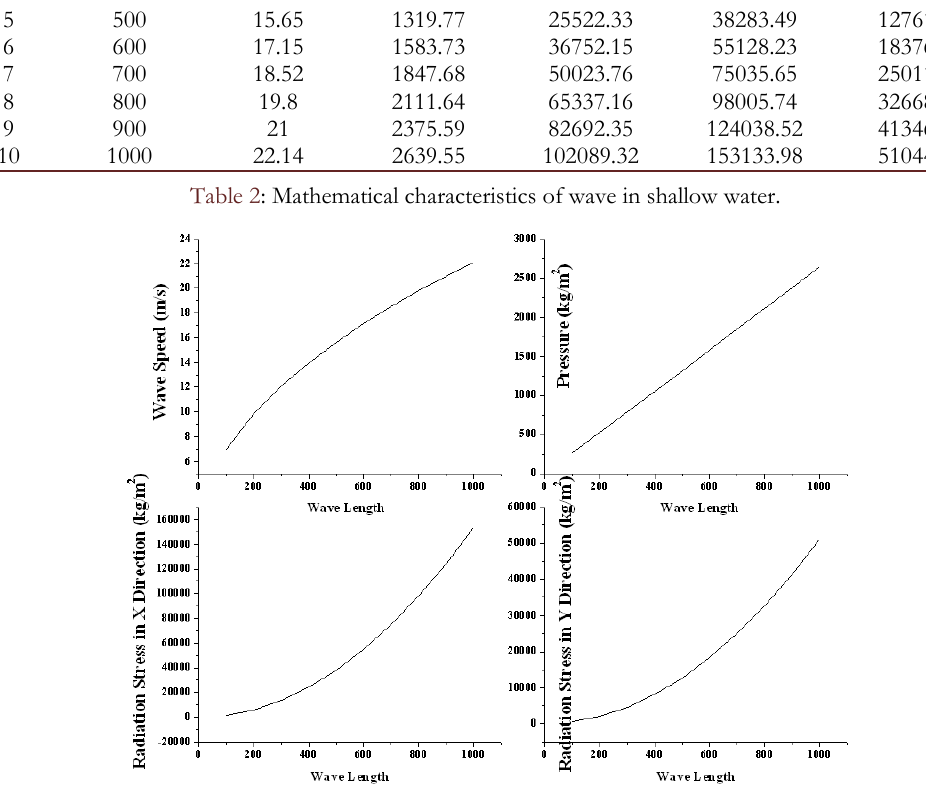
Figure 2: Mathematical characteristics of wave in shallow